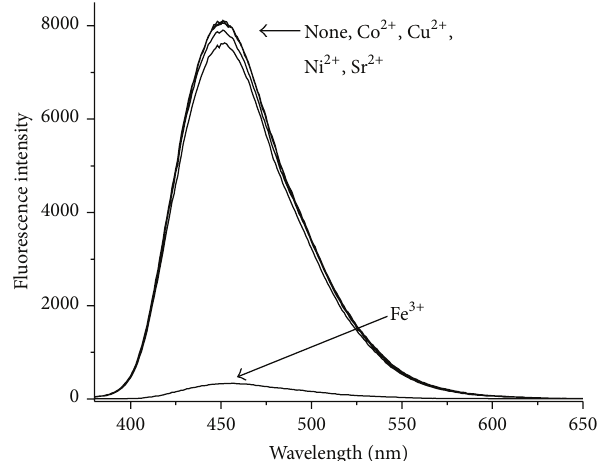
Figure 4: Effect of the metal cations at concentration 𝑐 = 2 × 10 −4 molL −1 on the fluorescence of poly(St-co-MD1) in aqueous solution.